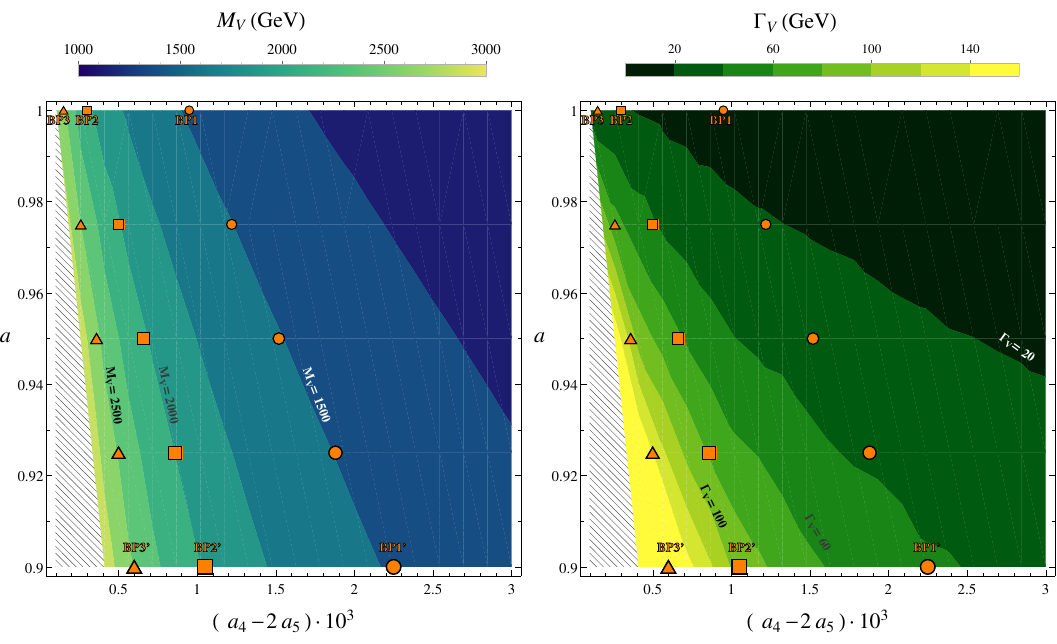
Figure 4 . Predictions for masses (left panel) and widths (right panel) of vector resonances as a function of a and the combination ( a 4 2 a 5 ) in the EChL+IAM. Our (cid:12)fteen selected scenarios (cid:0) lay approximately over the contour lines of (cid:12)xed M V , 1500 GeV (circles), 2000 GeV (squares), and 2500 GeV (triangles), and have values for a (cid:12)xed, respectively, to 0.9 (biggest symbols, corresponding to BP1’, BP2’ and BP3’), 0.925, 0.95, 0.975 and 1 (smallest symbols, corresponding to BP1, BP2, and BP3). All studied cases with vector resonances are such that no corresponding scalar or tensor resonances appear. The stripped area denotes the region with resonances heavier than 3000